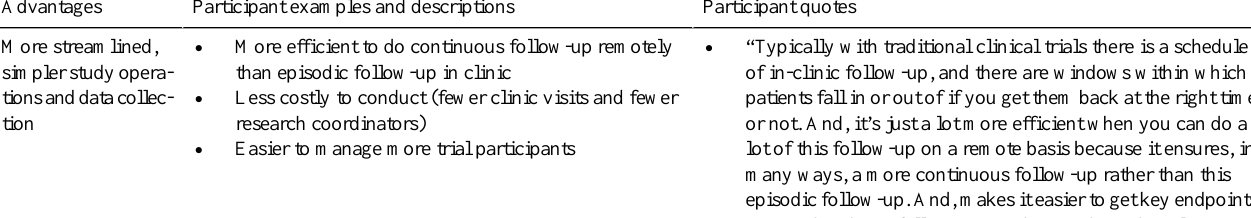
Table 3. General advantages of mobile clinical trials.